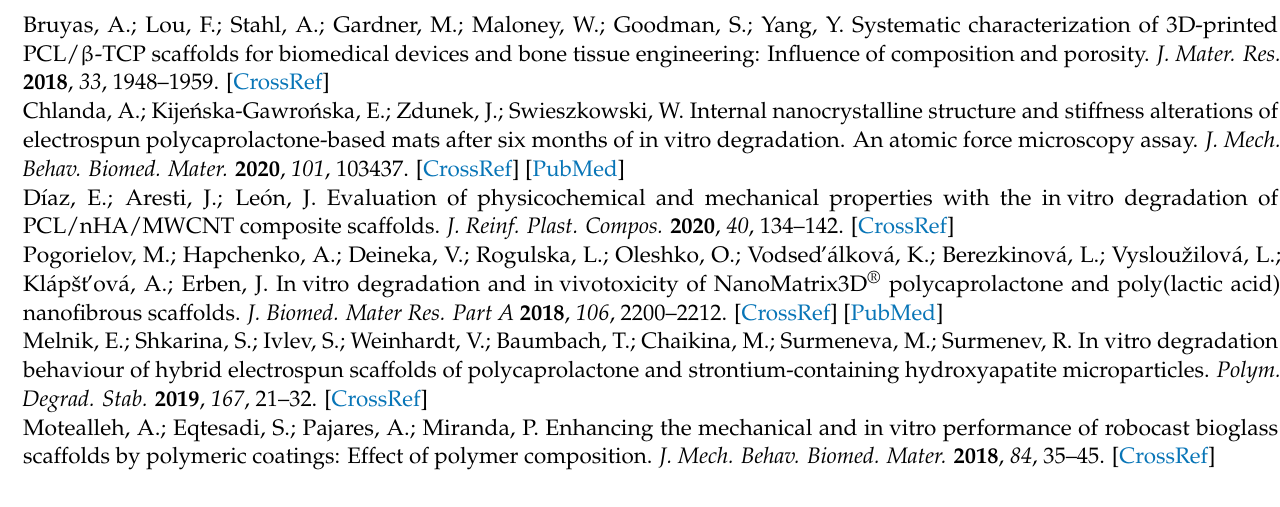
rectangular scaffolds with 500 µ m of pore size at different degradation time points. (A,B) Day 1; (C,D) Day 2; Figure S11. Top and cross section images of PCL/TCP rectangular scaffolds with 200 µ m of pore size at different degradation time points. (A,B) Day 1; (C,D) Day 2; (E,F) Day 3; (G,H) Day 4; (I,J) Day 5; Figure S12. Top and cross section images of PCL/TCP rectangular scaffolds with 300 µ m of pore size at different degradation time points. (A,B) Day 1; (C,D) Day 2; (E,F) Day 3; (G,H) Day 4; (I,J) Day 5; Figure S13. Top and cross section images of PCL/TCP rectangular scaffolds with 500 µ m of pore size at different degradation time points. (A,B) Day 1; (C,D) Day 2; (E,F) Day 3; (G,H) Day 4; (I,J) Day 5; Figure S14. Top and cross section images of PCL/bioglass rectangular scaffolds with 200 µ m of pore size at different degradation time points. (A,B) Day 1; (C,D) Day 2; Figure S15. Top and cross section images of PCL/bioglass rectangular scaffolds with 300 µ m of pore size at different degradation time points. (A,B) Day 1; (C) Day 2; Figure S16. Thermal Gravimetric Analysis (TGA) curves of bone bricks at different degradation times. (A) Day 1, (B) Day 2, (C) Day 3, (D) Day 4 and (E) Day 5; Figure S17. Thermal Gravimetric Analysis (TGA) curves of bone bricks samples as a function of degradation time for different material compositions. (A) PCL, (B) PCL/HA, (C) PCL/TCP and (D) PCL/bioglass; Figure S18. Glass transition temperature and heating curves for bone bricks containing different material composition as a function of degradation time. (A) Glass transition temperature on day 0, (B) Heating curve on day 0, (C) Glass transition temperature on day 1, (D) Heating curve on day 1, (E) Glass transition temperature on day 2 and (F) Heating curve on day 2, (G) Glass transition temperature on day 3, (H) Heating curve on day 3, (I) Glass transition temperature on day 4, (J) Heating curve on day 4, (K) Glass transition temperature on day 5 and (L) Heating curve on day